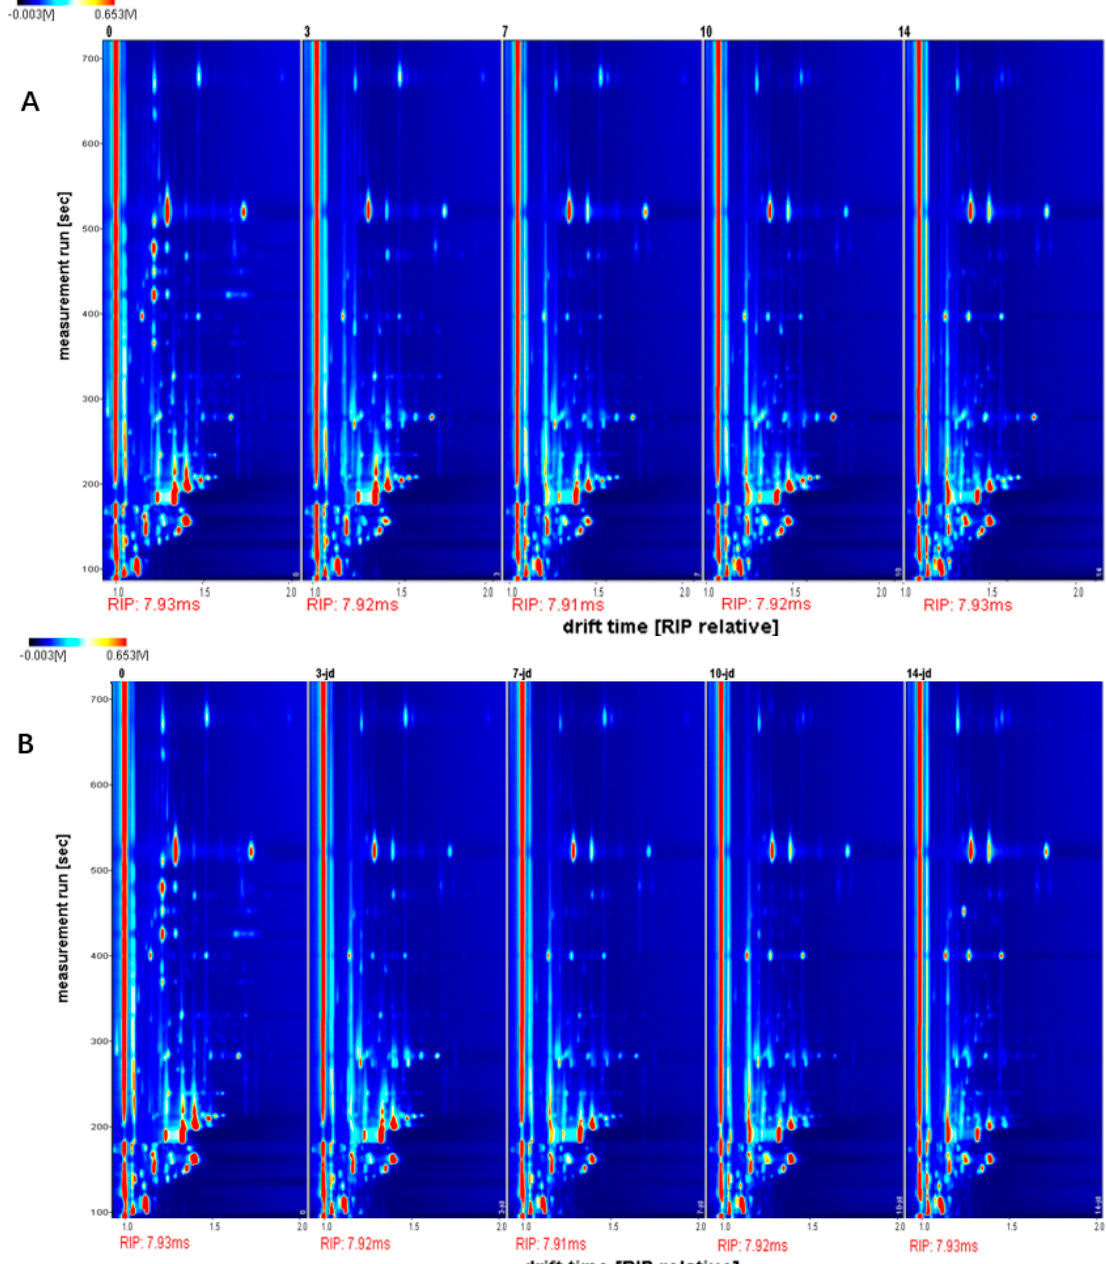
Figure 3. Two ‐ dimensiona topographic plots of dry ‐ cured beef at different times. Storage of dry ‐ cured beef in a common refrigerator is shown in ( A ), 0, 1, 3, 7, 10, and 14 represent refrigeration for 0, 1, 3, 7, 10, and 14 days, respectively. Storage of dry ‐ cured beef in a high ‐ voltage electrostatic field is shown in ( B ), 0, 3 ‐ jd, 7 ‐ jd, 10 ‐ jd, and 14 ‐ jd represent refrigeration for 0, 3, 7, 10, and 14 days, respectively.